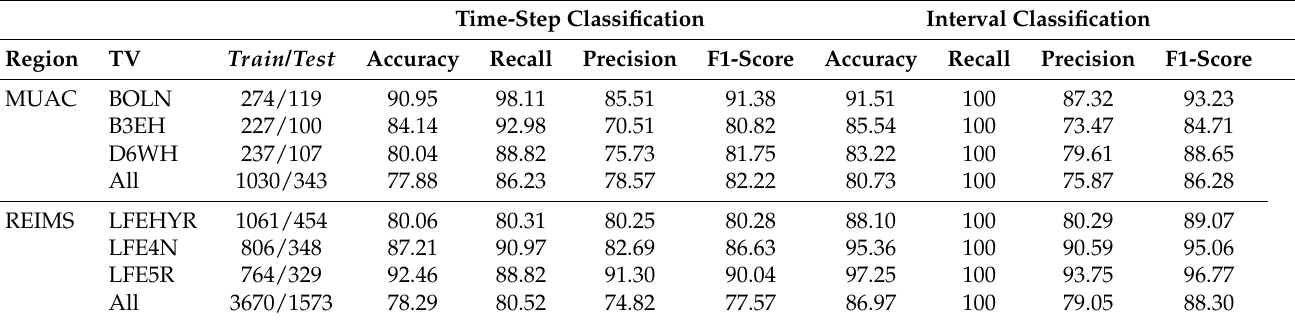
Table 1. Performance of the RNN-based model for different TVs in the MUAC and REIMS regions at the time-step level, and at the interval level. Train/Test column shows the number of 30 min intervals